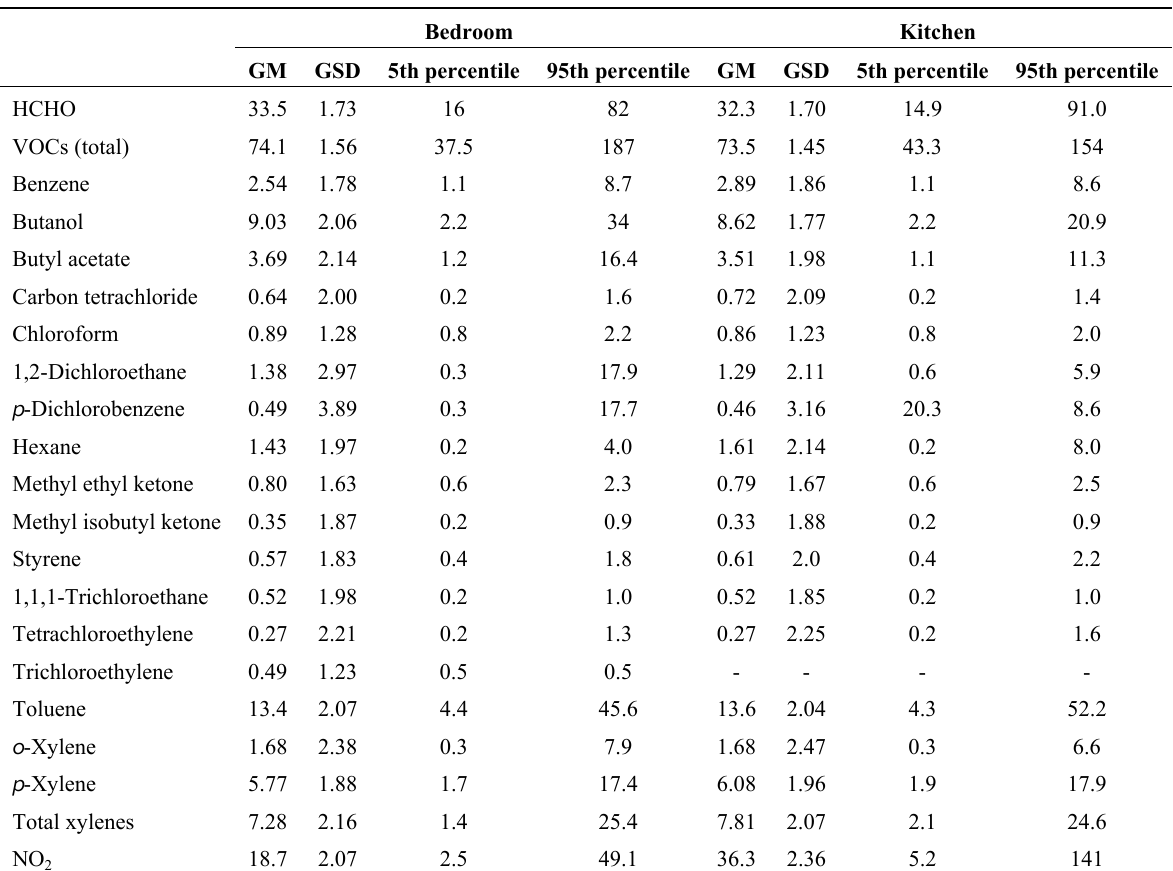
Table 3. Geometric mean concentrations (GM), geometric standard deviation (GSD) and 5th and 95th percentiles of HCHO, VOCs, and NO sampled flats (calculated from Table